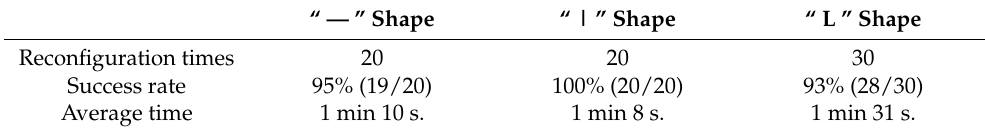
Table 2. Reconfiguration data. “ — ” Shape “ | ” Shape “ L ” Shape Reconfiguration times 20 20 30 Success rate 95% (19/20) 100% (20/20) 93% (28/30) Average time 1 min 10 s. 1 min 8 s. 1 min 31